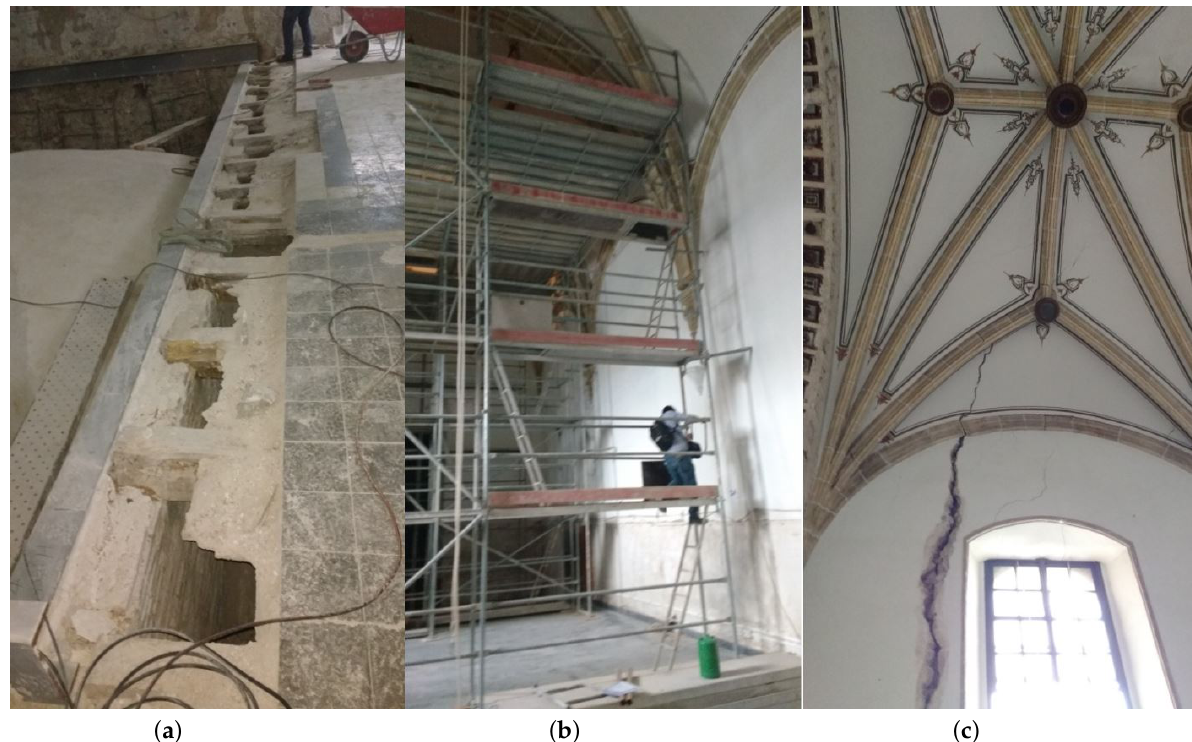
Figure 3. Construction process in the restoration. ( a ) Original slab floor with horizontal wood joists ( b ) Falsework for stability guarantee in the works ( c ) the active vertical fracture along wall and vaults disturb stability of the study complex that must be consolidated.